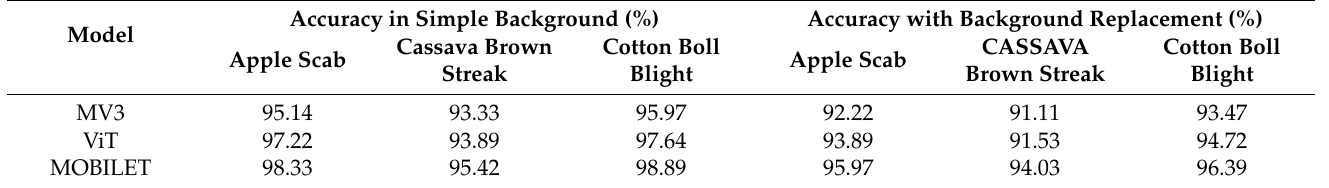
Table 7. Differences in generalization ability among different